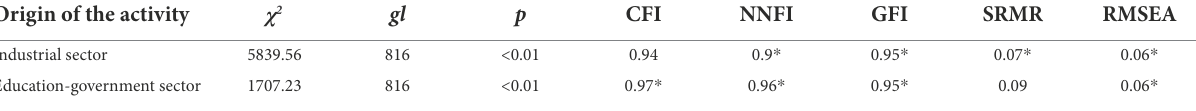
TABLE 7 Fit values for the configurational invariance model as a function of different sectors of activity. Origin of the